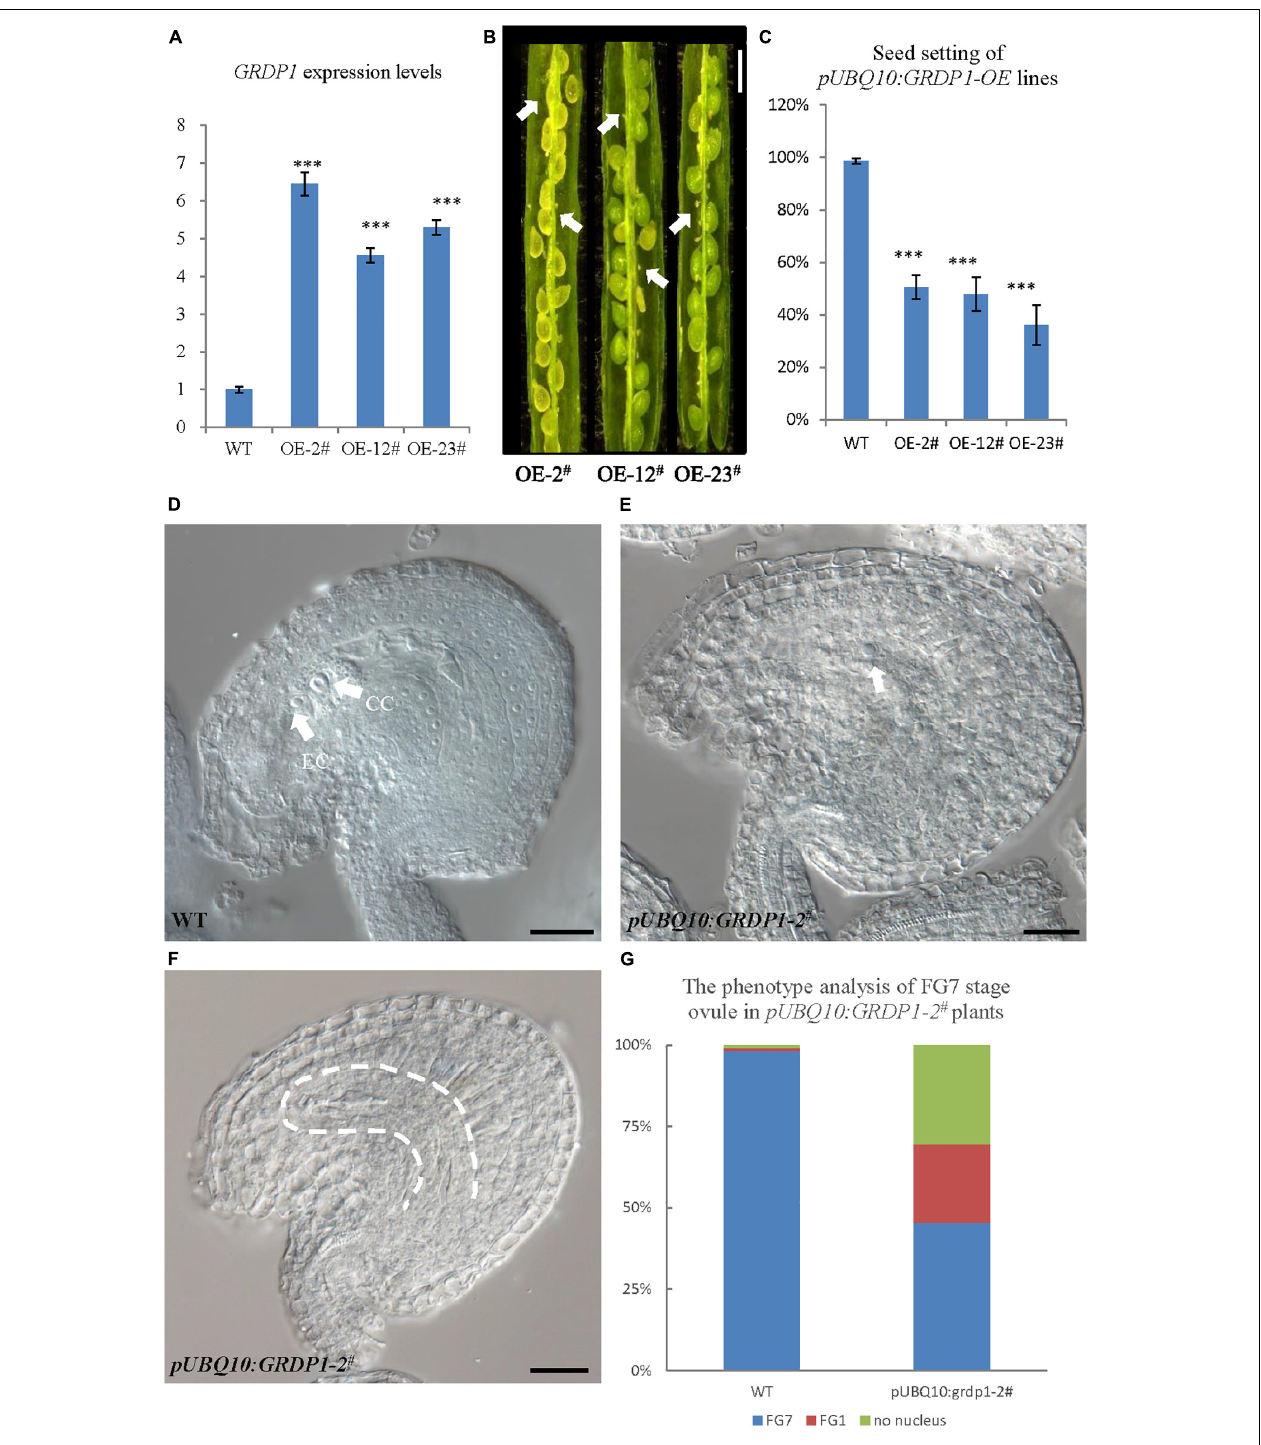
FIGURE 9 | Phenotype analysis of pUBQ10:GRDP1 -OE lines. (A) Expression levels of GRDP1 in WT, pUBQ10:GRDP1-OE-2 # , pUBQ10:GRDP1-OE-12 # , and pUBQ10:GRDP1-OE-23 # as determined by real-time RT-PCR. (B) Seed development in three pUBQ10:GRDP1-OE line plants. Bar = 0.5 cm. (C) Seed setting statistics of the WT, pUBQ10:GRDP1-OE-2 # , pUBQ10:GRDP1-OE-12 # , and pUBQ10:GRDP1-OE-23 # lines. (D) The FG7 stage ovules from WT plants. (E,F) The FG7 stage ovules from pUBQ10:GRDP1-OE-2 # plants, 24.1% of 196 examined FG7 stage ovules showed single nucleus, 30.6% of 196 examined FG7 stage ovules showed no nucleus. (G) The phenotype analysis of FG7 stage ovules in WT and pUBQ10:GRDP1-OE-2 # plants. Vertical bars represent the mean ± SD as determined by two technical replicates of three biological replicates; asterisks show the significance level judged by Student’s t -test ( ∗∗∗ p < 0.01). CC, central cell; EC, egg cell. White arrows mean nuclei; white dotted lines mean embryo sac.